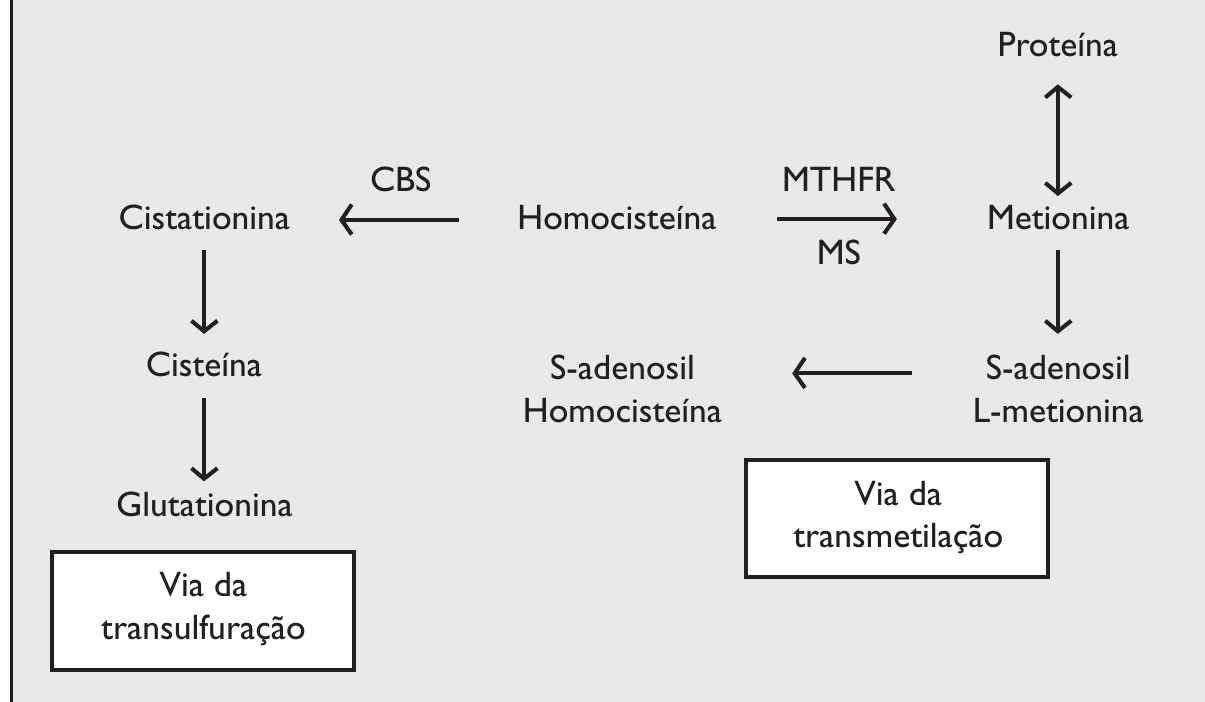
Figura 2 – Visão diagramática das vias de metabolismo da homocisteína e da metionina (51) MTHFR = metileno-tetraidrofolato redutase; C β S = cistationina β -sintetase; MS = metionina